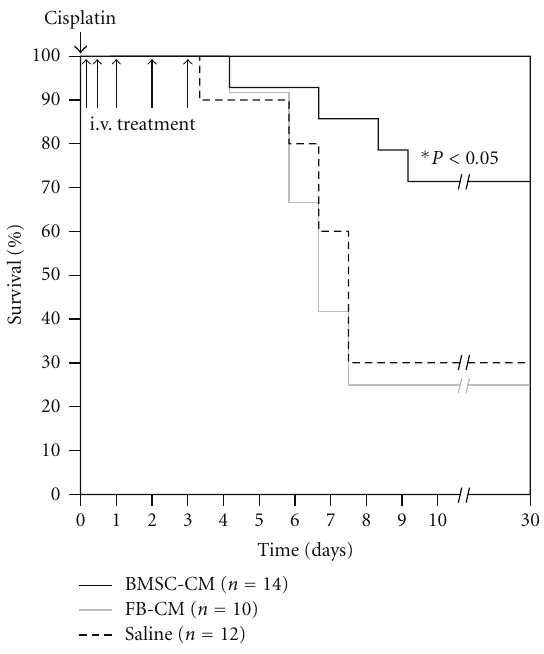
Figure 1: BMSC-CM confers a significant survival benefit to rats undergoing lethal cisplatin -induced AKI . At hour 0, cisplatin dissolved in physiological saline (0.75 mg/mL) was administered i.p. to male, SAS-SD rats at a lethal dose (7.5mg/kg). At hours 3, 9, 24, 48, and 72, 1 mL of either physiological saline ( n = 12), fibroblast conditioned medium ( n = 10) or BMSC-conditioned medium ( n = 14) were administered i.v. to the cisplatin-treated AKI rats. They were monitored for survival for 30 days. ∗ P < 0 . 05 for BMSC- CM compared to both FB-CM and saline by Logrank